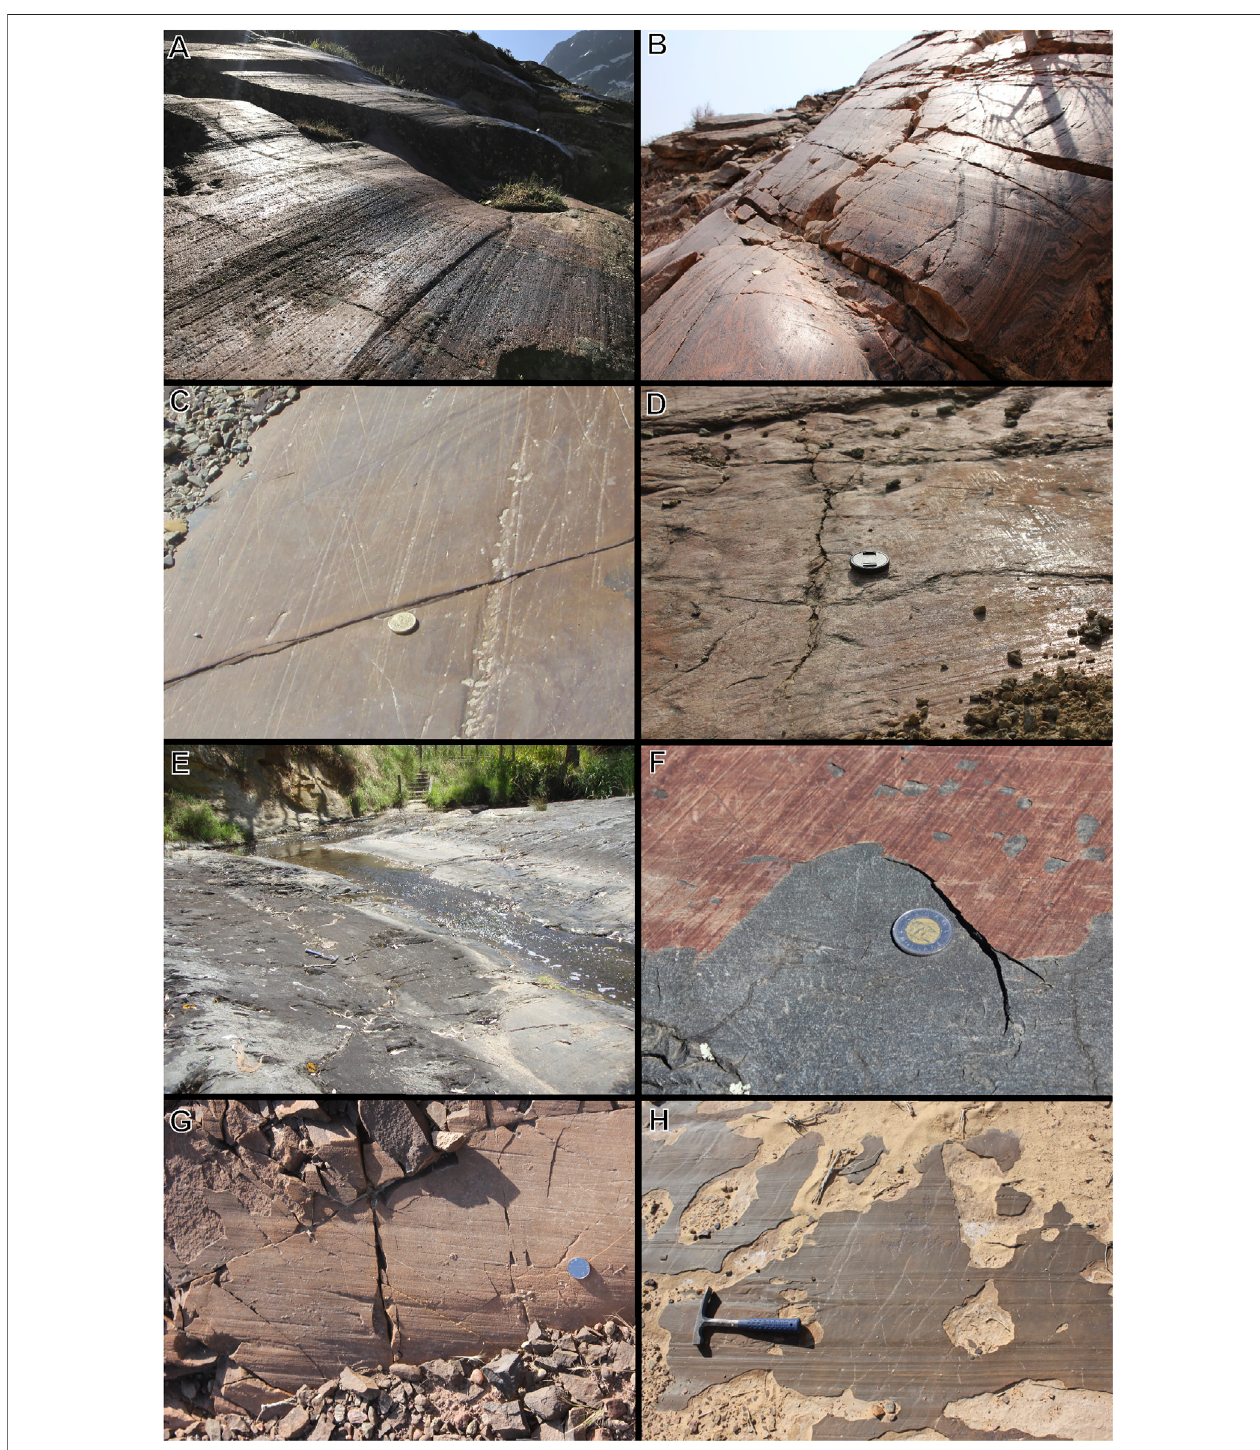
FIGURE7| Striatedsurfacesthroughspaceandtime. (A) Polishedbedrock(paragneiss)exposedinrecentdecadesfollowingtheretreatoftheGepatschGlacierin Kaunertal, Austria. (B) Polished bedrock (orthogneiss) in northern Namibia, which was glaciated approximately 300 million years ago (Dietrich et al., in press). (C) Early Permian striated surface developed on Neoproterozoic siltstone at Hallett Cove, South Australia. Note crosscutting striations and chatter marks. (D) Surface sheen (glacial polish) at Pingdingshan, central China, reveals evidence for two contrasting fl ow directions beneath and Ediacaran ice sheet. (E) Interaction of a modern creek with an early Permian grooved and ridged surface at Glacier Rock, South Australia. (F) The peeling crust of glacial varnish, preserving striations, weathers away from paragneiss bedrock in Ontario, Canada. This surface is of Pleistocene age and is associated with MSGLs developed in bedrock (Krabbendam et al., 2016). (G) Probable late Cryogenian striated pavement in the Tarim Craton, NW China, beneath the Yuermeinak Formation (see Vandyk et al., 2019). (H) Example of a peeling and highly weathered soft-sediment striated surface (e.g., Le Heron et al., 2020) from the Late Ordovician of Saudi Arabia.